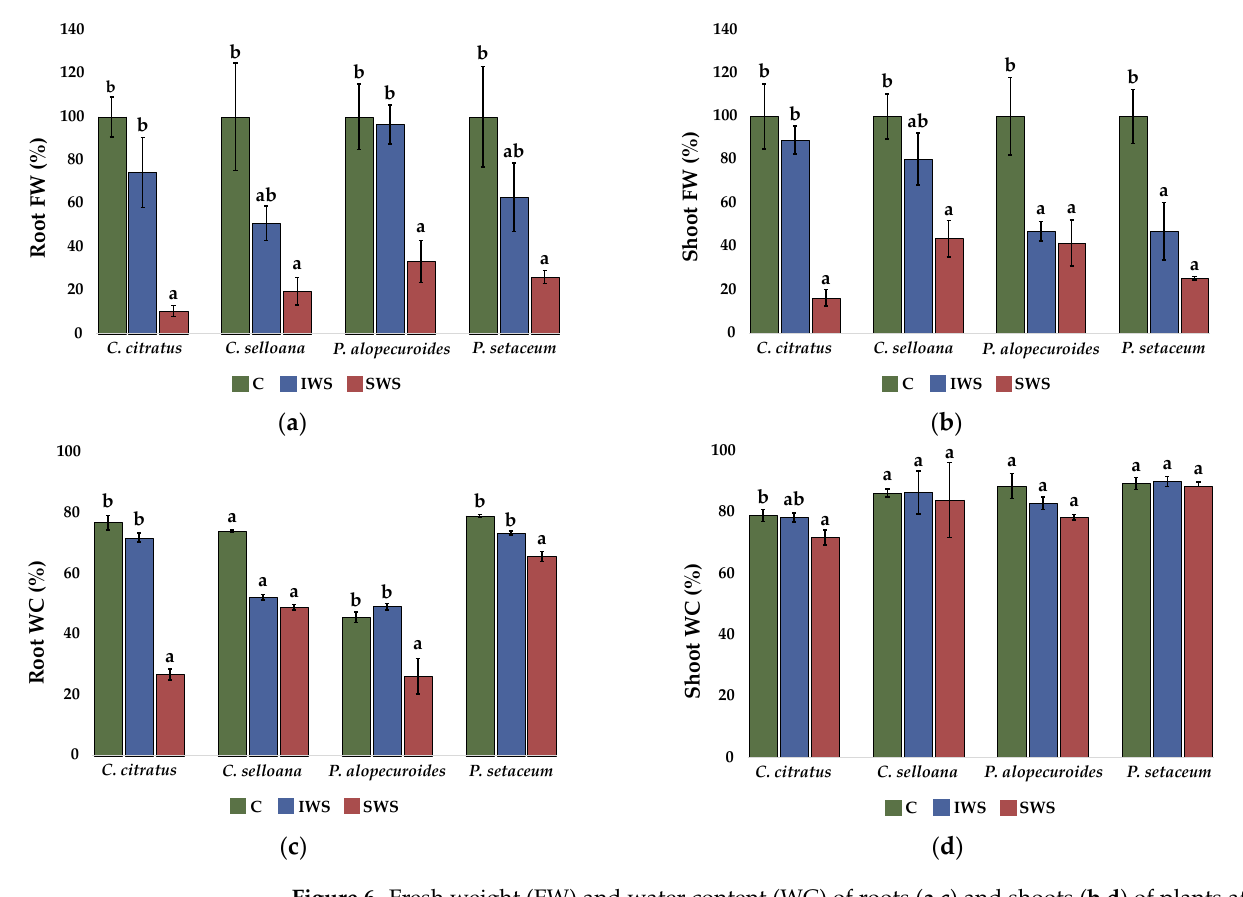
Figure 6. Fresh weight (FW) and water content (WC) of roots ( a , c ) and shoots ( b , d ) of plants after 30 days of stress treatments. Values are means ± SE ( n = 5). For each studied species, root and shoot FW of stressed plants are expressed as percentages of the average control values for each parameter, taken as 100%. Absolute control values for root FW are: 4.73 g, 1.09 g, 1.03 g and 4.13 g, for C. citratus , C. selloana , P. alopecuroides and P. setaceum , respectively; the corresponding values for shoot FW are: 6.25 g, 4.51 g, 3.50 g and 15.20 g, respectively. Different lowercase letters over the bars indicate sig ‐ nificant differences between treatments (CON—control; IWS—intermediate water stress; SWS—se ‐ vere water stress), for each species, according to the Tukey test ( p < 0.05). Table 3. Effect of stress treatments on the dry weight of roots and shoots ( n = 5). Different lowercase letters indicate significant differences between treatments with each species per parameter accord ‐ ing to the Tukey test ( p < 0.05).